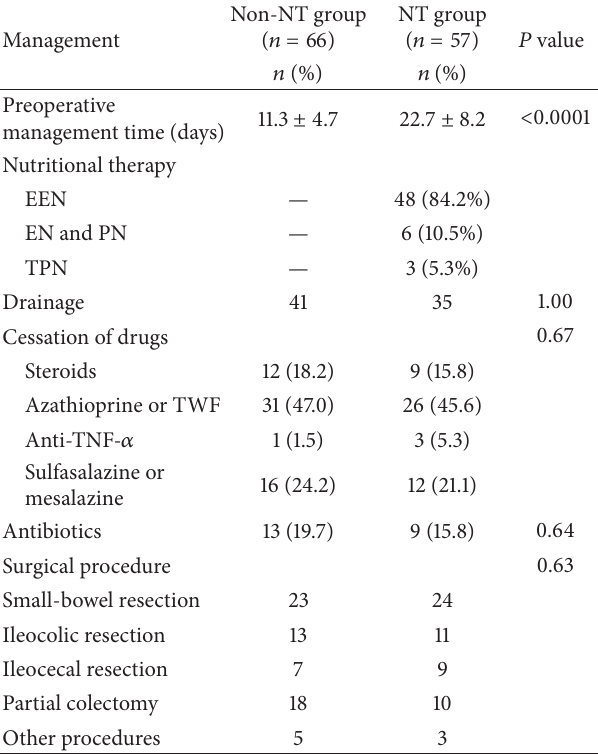
Table 2: Preoperative management and surgical